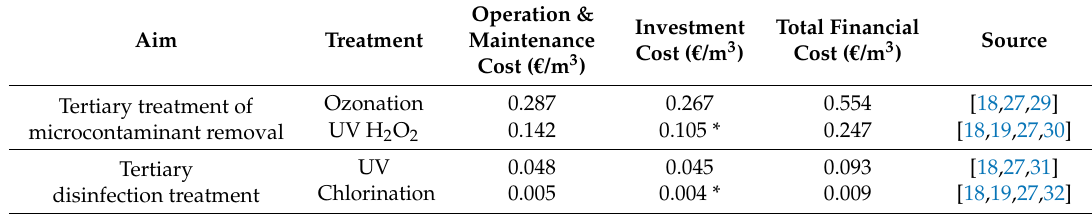
Table 3. Cost of tertiary treatments with environmental and reuse objectives updated to 2014.